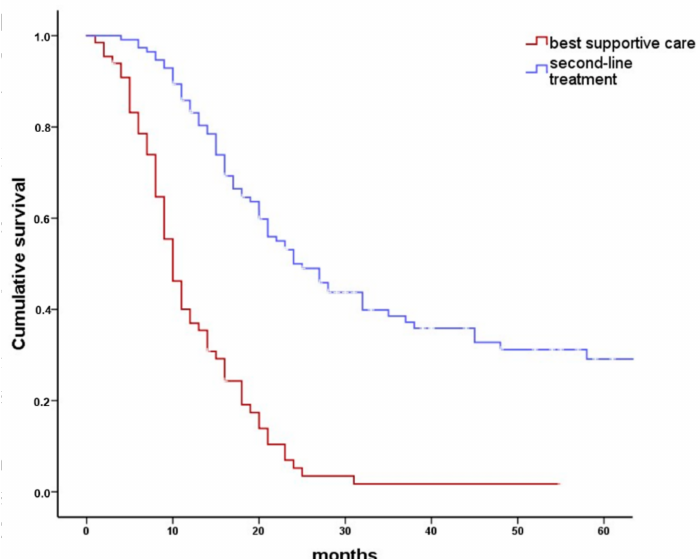
Figure 3. Overall survival after any second-line therapy compared to best supportive care (BSC).